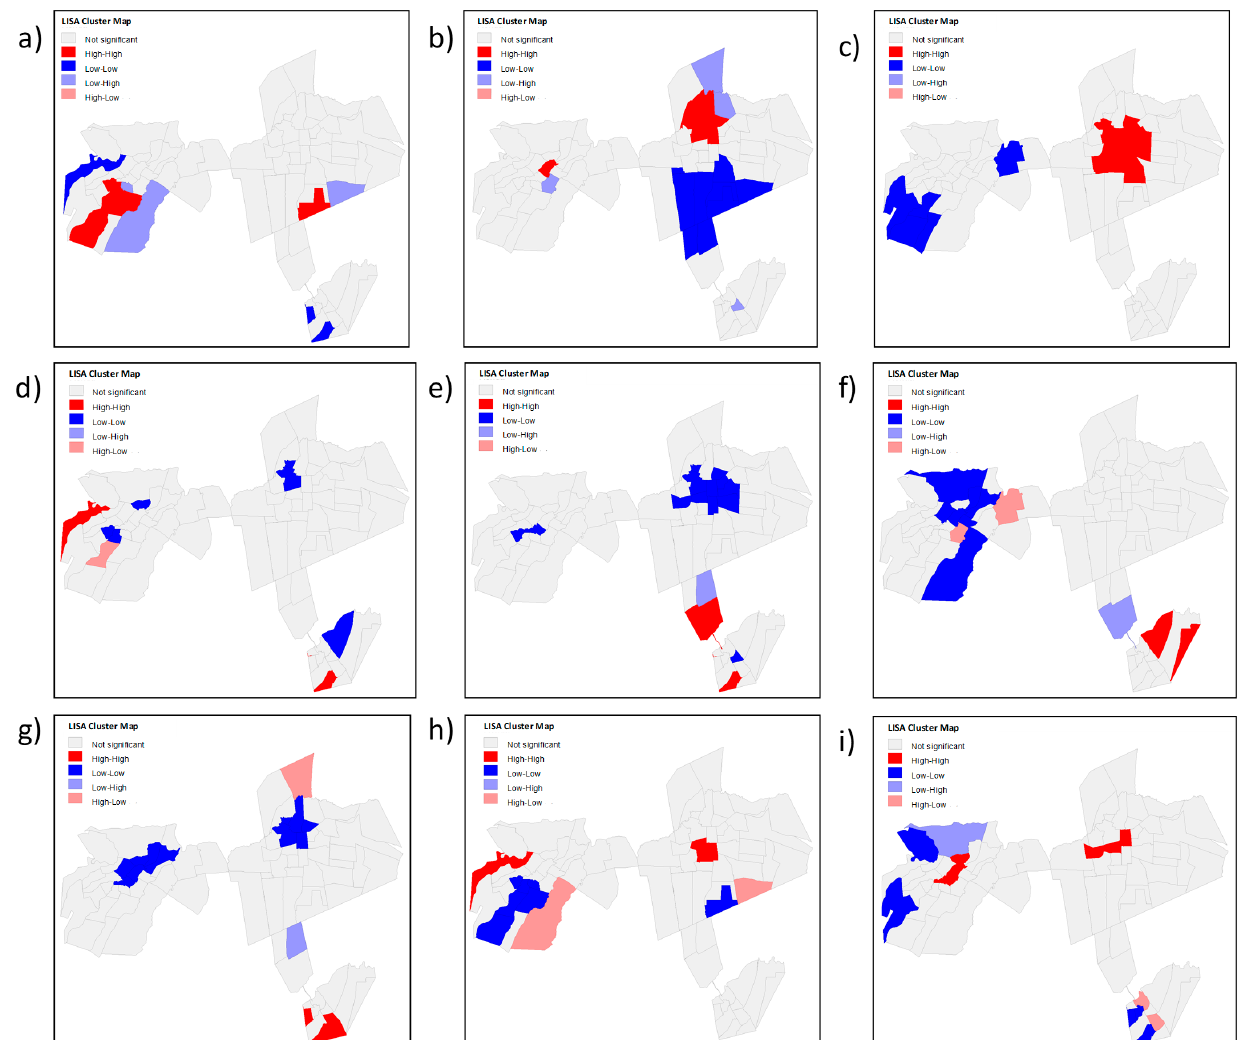
Figure 4. Univariate local autocorrelation maps relating to the total number of COVID-19 cases and the independent variables (PEVI and the indicators that comprise it): ( a ) low income distribution;